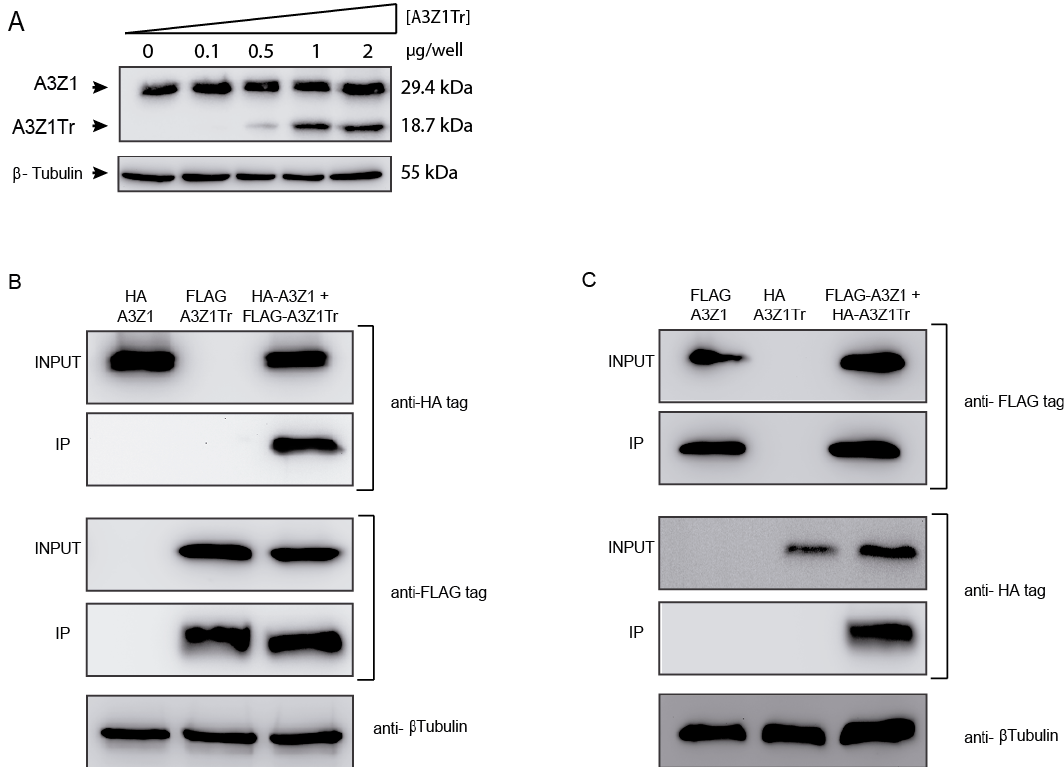
Figure 3. APOBEC3Z1 expression and interaction. ( A ) HA-tag detection in 293T cells transfected with 1 µg of A3Z1 and increasing amounts of A3Z1Tr; ( B ) 293T cells were co-transfected with plasmids expressing A3Z1 tagged with HA and A3Z1Tr tagged with FLAG epitopes and after 48 h were immunoprecipitated with anti-FLAG beads. Input lysates and co-immunoprecipitated samples (IP) were immunoblotted by anti-HA or anti-FLAG monoclonal antibodies; ( C ) reverse pull-down experiment. 293T cells were co-transfected with A3Z1-FLAG and A3Z1Tr-HA epitopes and after 48 h were immunoprecipitated with anti-FLAG beads. Input lysates and co-immunoprecipitated samples (IP) were immunoblotted by anti-HA or anti-FLAG monoclonal antibodies. β -tubulin blot was used as loading control.